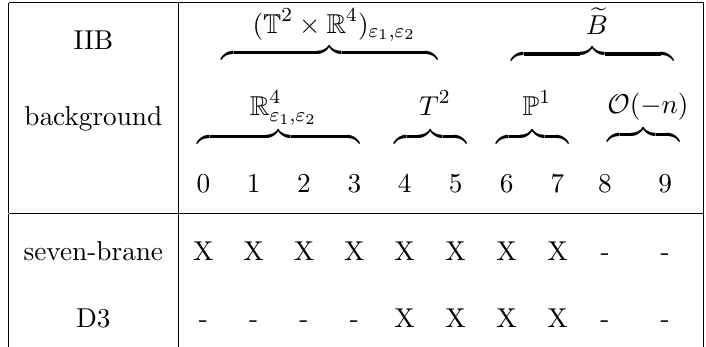
Figure 4 . Gaiotto T 3 theory from degeneration of the SU(3) ; N f = 6 curve.